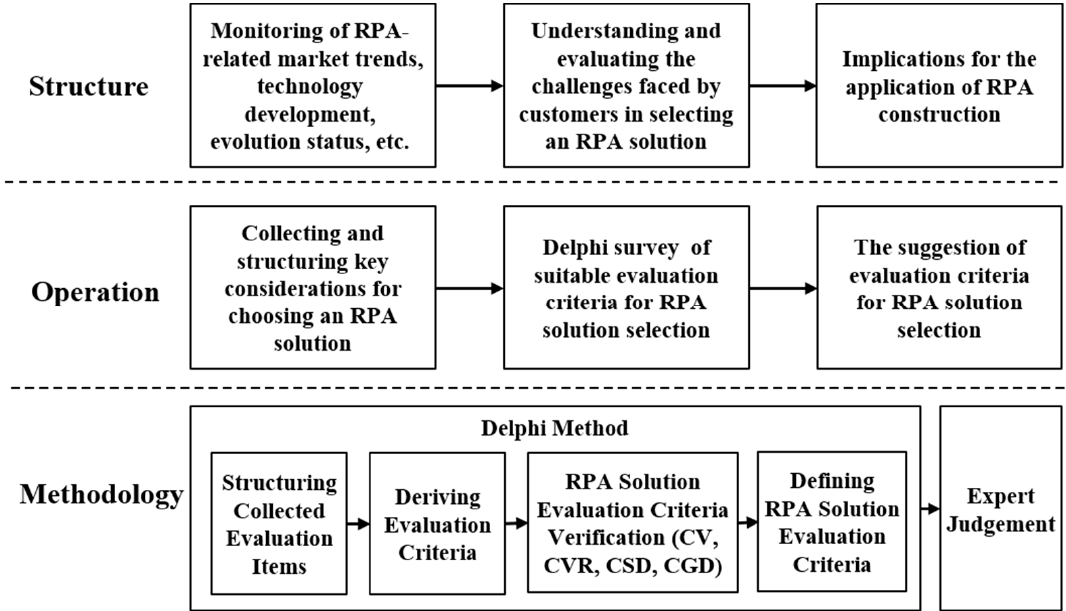
Figure 5. Overview of research process and methodology.